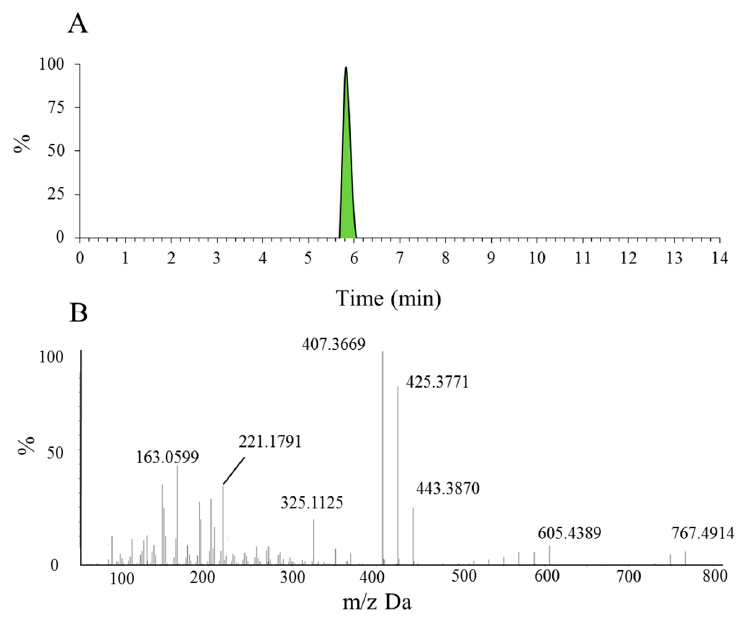
Figure 2. The extracted ion chromatogram of Rg5 ( A ) and the MS/MS spectrum of Rg5 using ESI in positive ion mode ( B ).